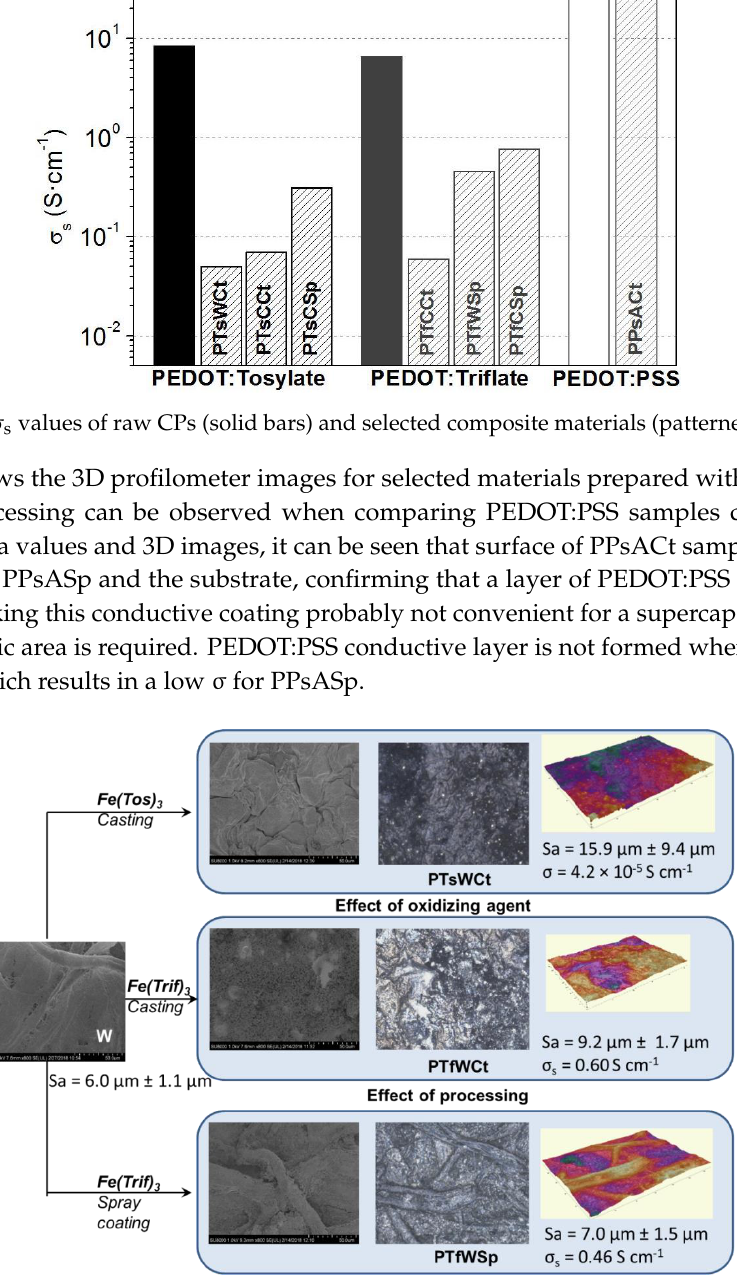
Figure 5. SEM micrographs and 3D profilometer images of W composites prepared by in-situ